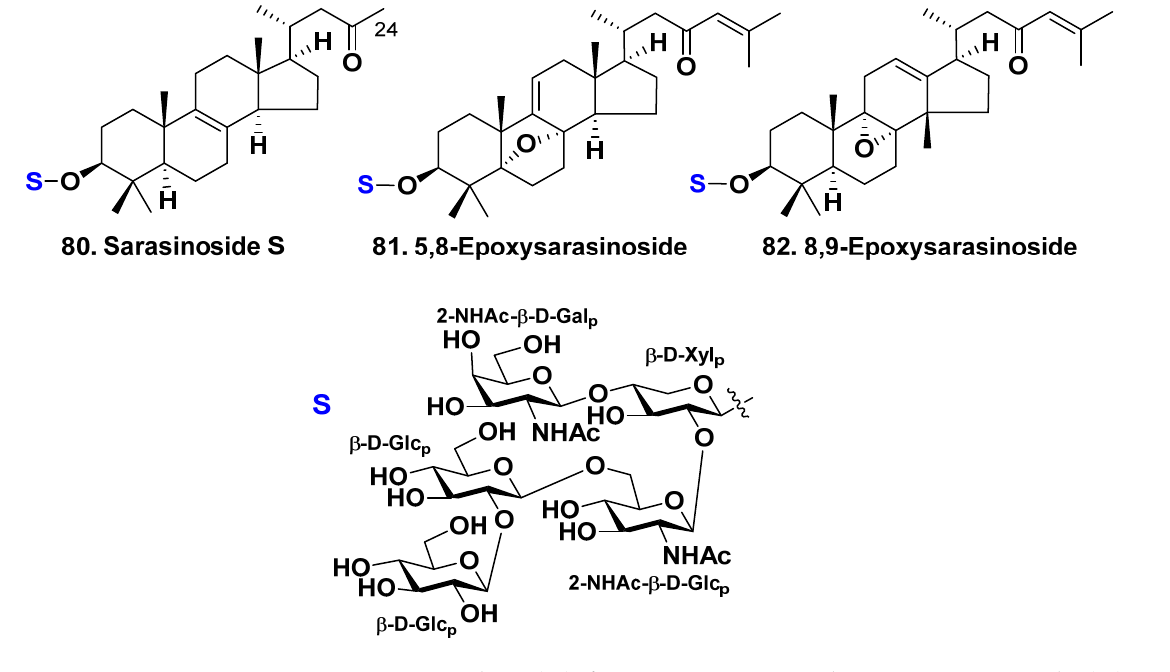
Figure 9. Sarasinoside S ( 80 ) from Petrosia sp. and 5,8-epoxysarasinoside ( 81 ) and 8,9- epoxysarasinoside ( 82 ) from Petrosia nigricans